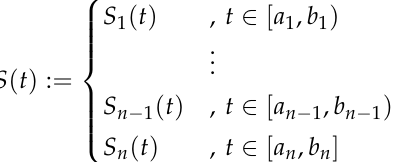
Figure 6. Perturbation Splines: A two-minute section of a biobot’s estimated speed trajectory is shown. ( t ) , is shown in blue. The perturbed speed trajectory, ˆ s l ∗ The interpolated speed trajectory, ˆ s l lb ( t ) and ˆ s l ( t ) are magnified in the inset picture to highlight the fact that the is shown in orange. ˆ s l ∗ lb lb trajectories are different. The knot locations of the speed perturbation spline are marked with magenta squares. Additionally, data points that have zero speed are marked with red x’s. Notice how ˆ s l ∗ ( t ) —this behavior is achieved by using the algorithm discussed zero during the stationary sections of ˆ s l lb in Section